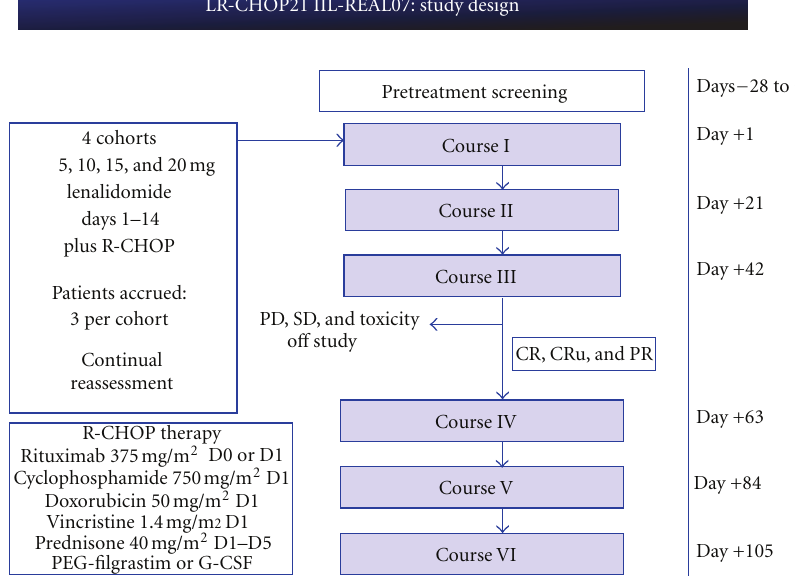
Figure 3: Phase I/II trial of Italian Lymphoma Foundation for elderly untreated